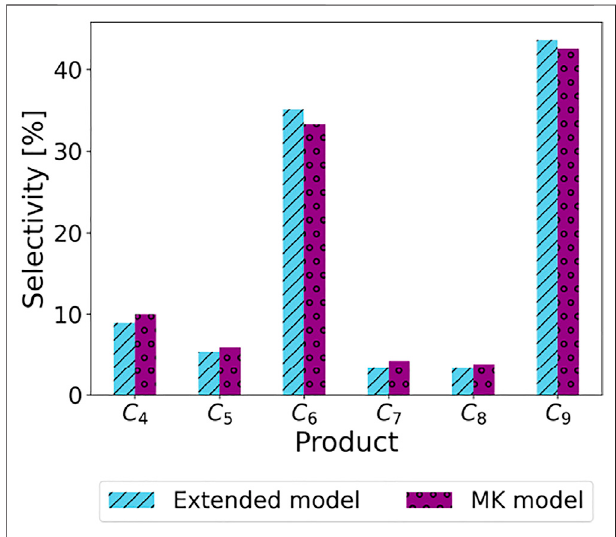
FIGURE 2 | Product selectivity for butene and heavier ole fi ns using MK (Vernuccio et al., 2019) and extended MK models at 10 bar feed pressure.